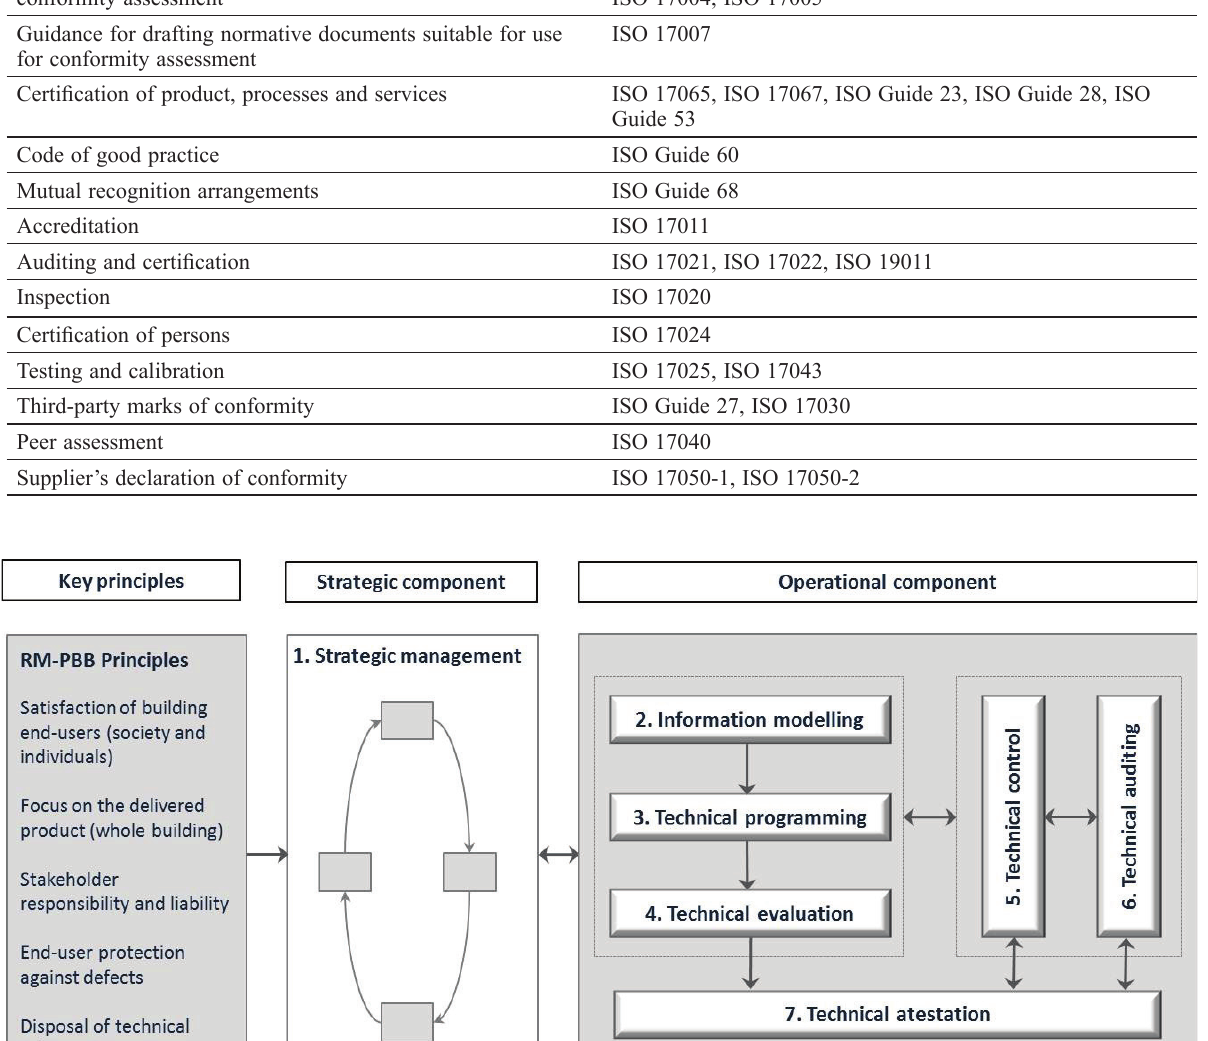
Vocabulary, general principles and common elements of conformity assessment Guidance for drafting normative documents suitable for use for conformity assessment